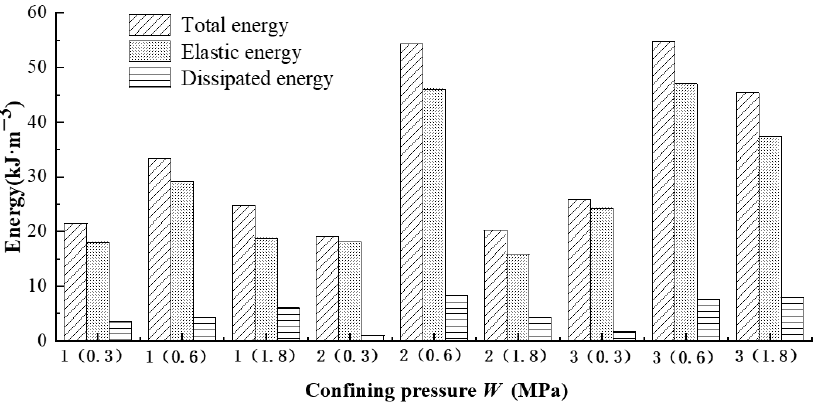
Figure 10. Energy distribution chart of rock sample.